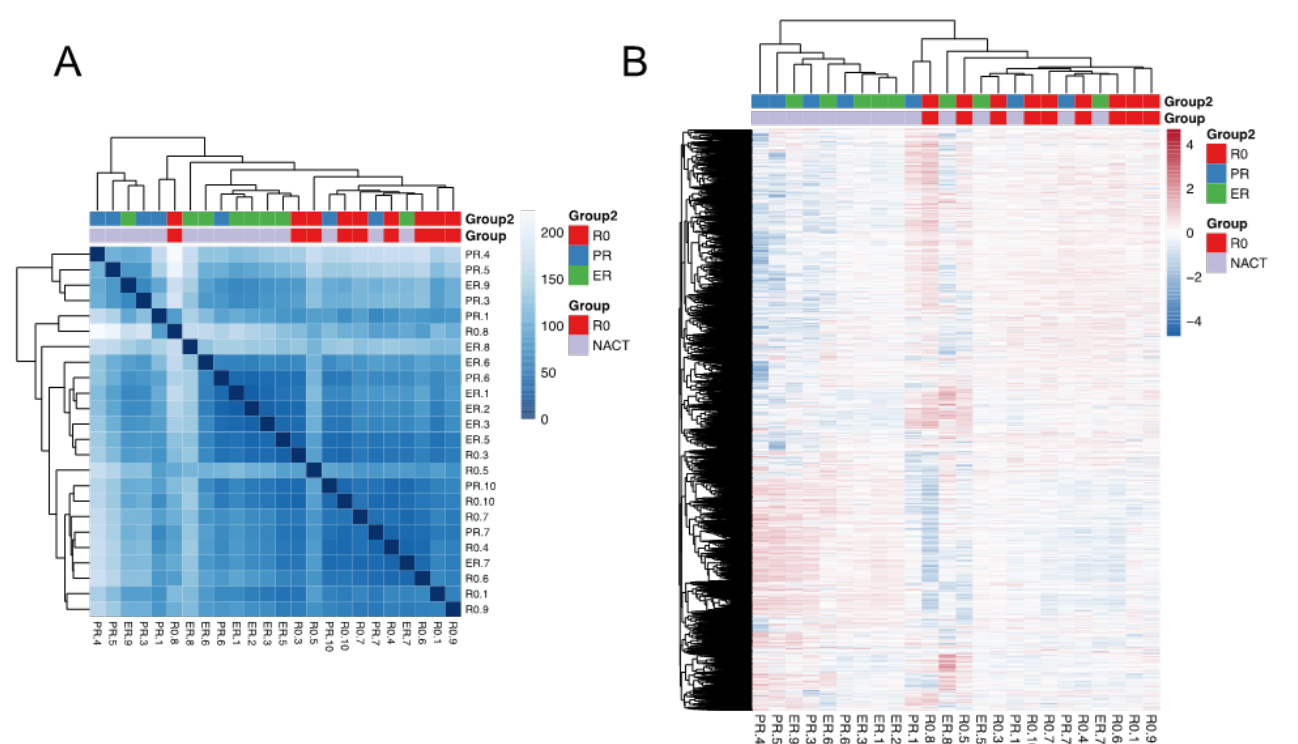
Figure 3. Sequencing analysis for 24 EV-RNA samples. Clustering of samples according to EV-RNA expression is shown; samples tend to cluster according to R0 and NACT groups. ( A ) Heatmap of sample-to-sample distance. ( B ) Unsupervised clustering of the top 10,000 most variable genes. ER = excellent response to neoadjuvant chemotherapy (NACT); PR = poor response to NACT; R0 = no residual disease; EV = extracellular vesicles.